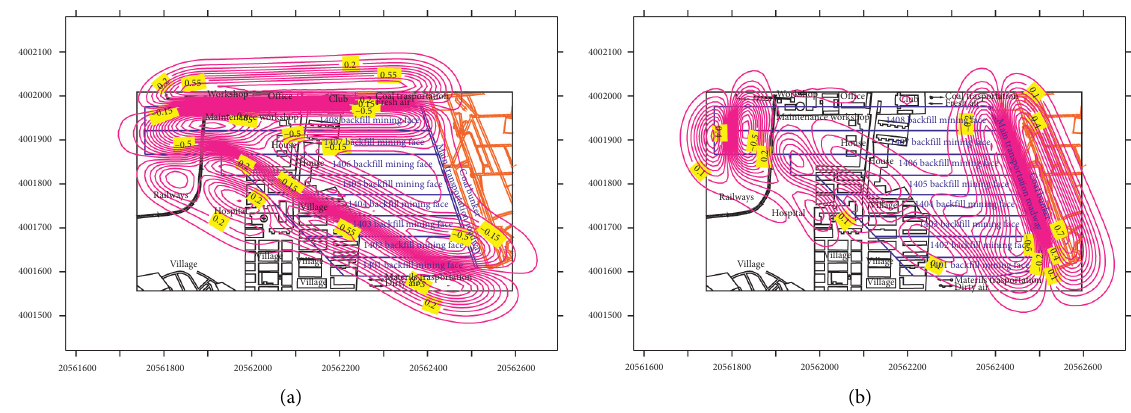
Figure 5: Contour map of horizontal surface deformation in RMCPB.